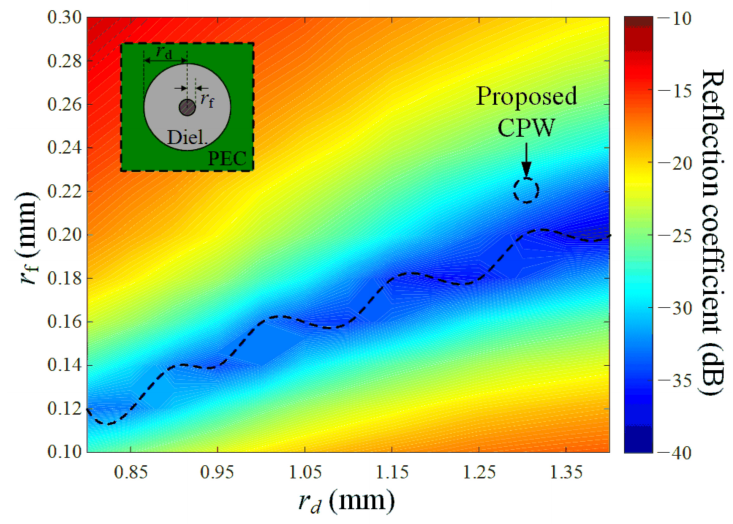
Figure 6. The reflection coefficients in accordance with r f and r d in transition part C